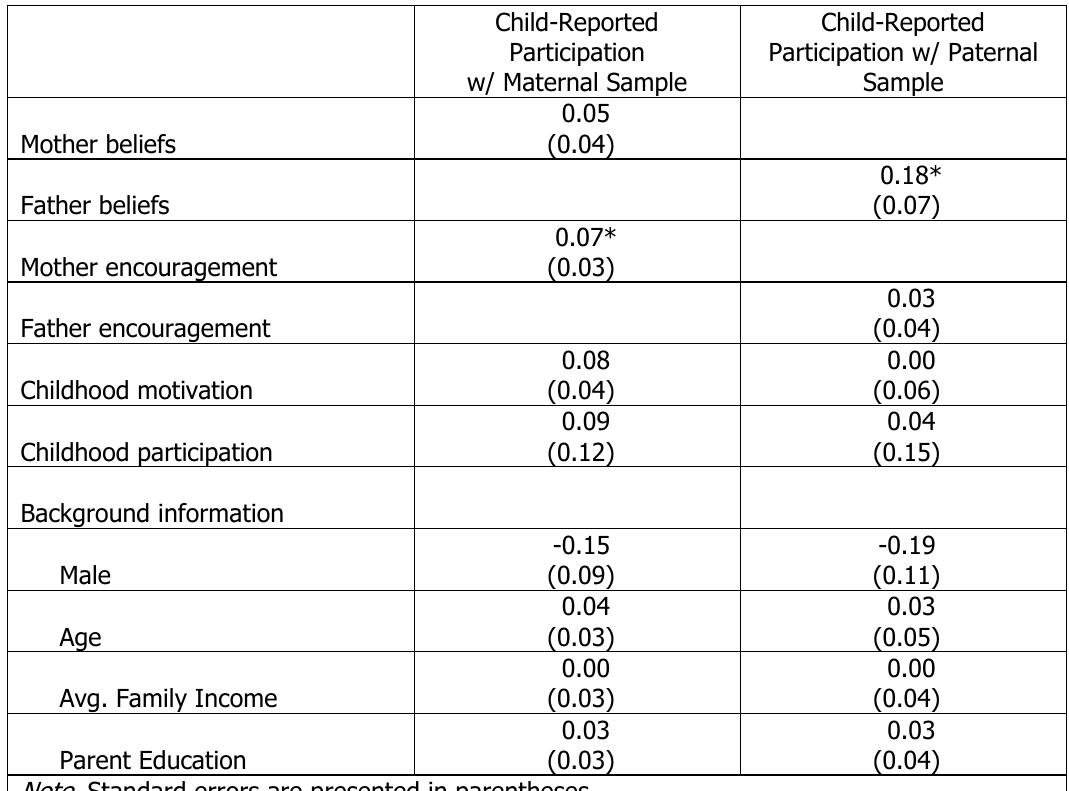
Marginal effects logistic regression results (N=153 Mothers, 93 Fathers) for middle childhood (Wave 4) measures predicting whether youth reported participating in organized sports in adolescence (Wave